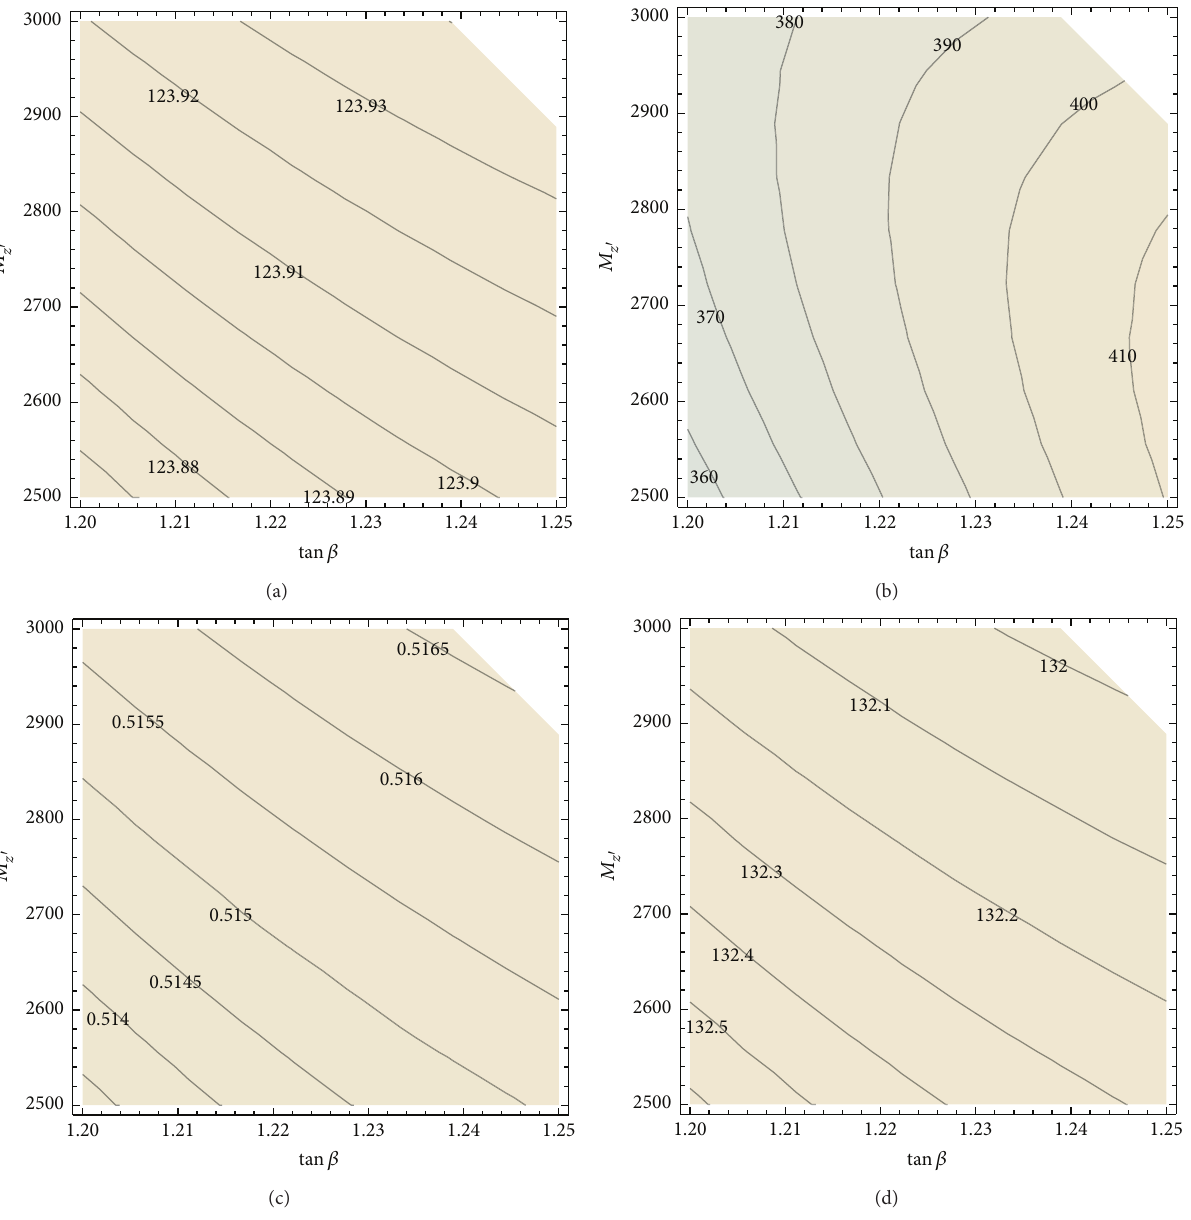
Figure 13: The two lightest scalar Higgs masses (top row), the “ obsratio ” as calculated by HiggsBounds (bottom left), and the total 𝜒 2 as calculated by HiggsSignals . Plots are produced with SSP using EP1 and making a grid scan in the ( tan 𝛽 󸀠 ; 𝑀 𝑍 󸀠 ) plane.